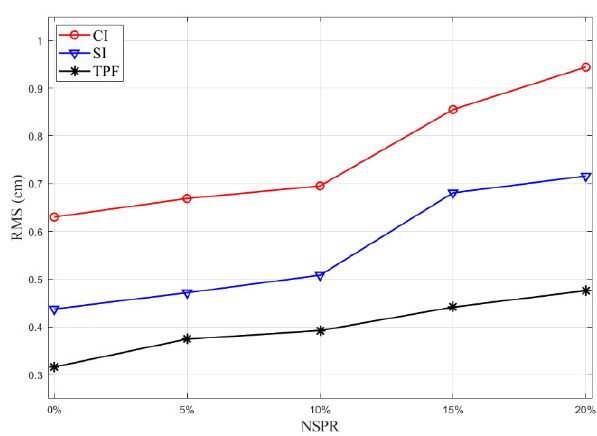
Figure 9. Variation in RMS with NSPR in TEs 5–8.